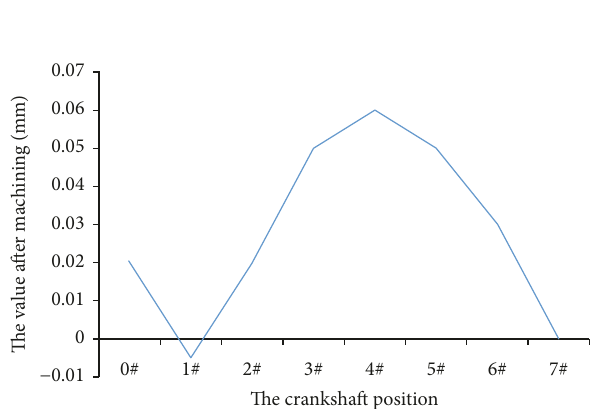
Figure 7: Distribution diagrams of the simulation of crankshaft hole.